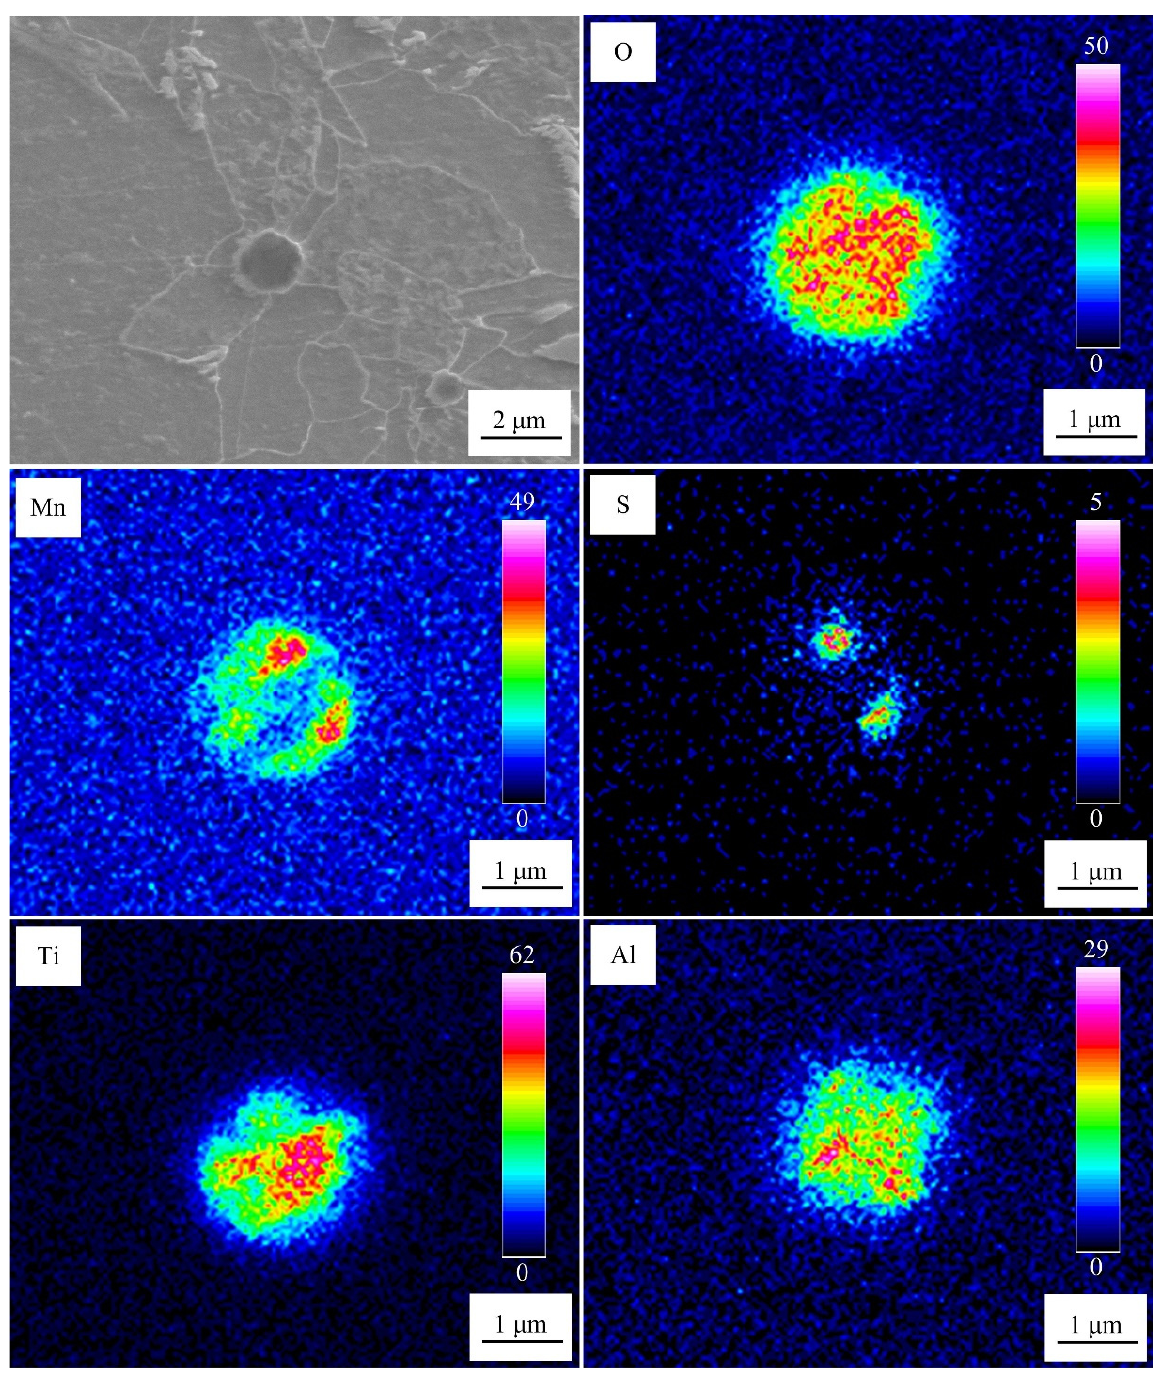
Figure 4. SEM ‐ EDS mapping image of inclusions in the weld metal at the cooling rate of 10 °C/s. Figure 4. SEM-EDS mapping image of inclusions in the weld metal at the cooling rate of 10 ◦